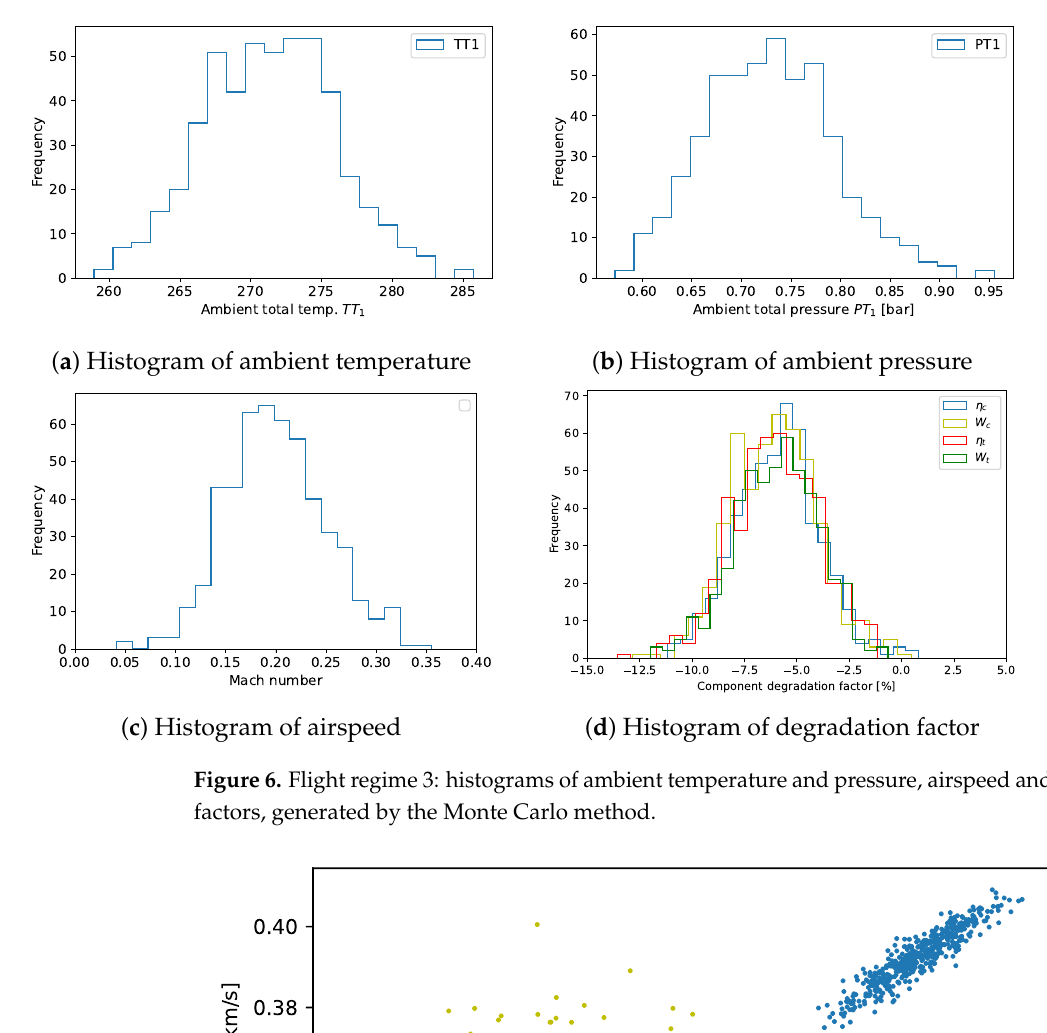
Figure 6. Flight regime 3: histograms of ambient temperature and pressure, airspeed and degradation factors, generated by the Monte Carlo method.